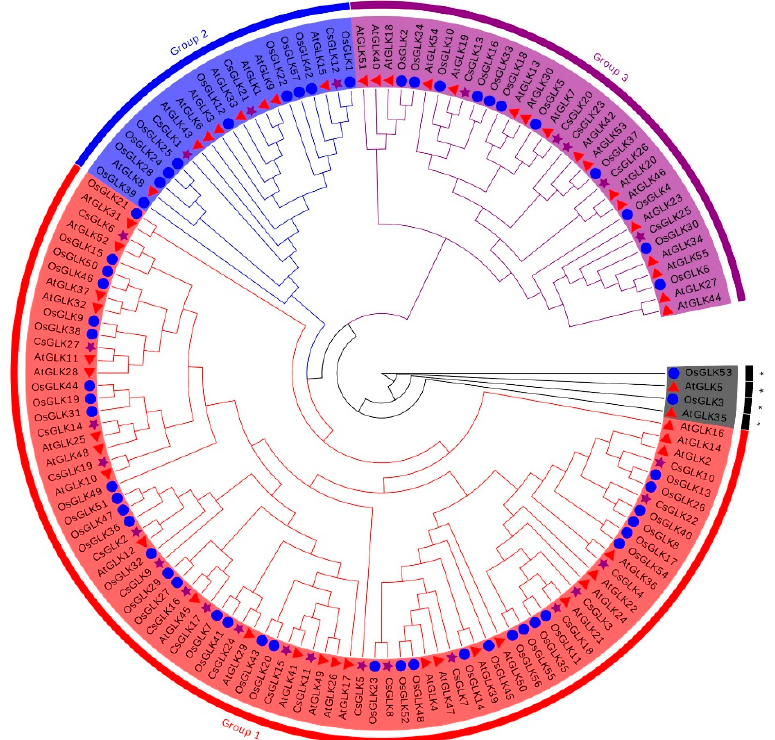
Figure 1. Phylogenetic analysis of Citrus sinensis, Arabidopsis thaliana and Oryza sativa GLKs. Circles of different colors represented different subgroups. ☆ represented citrus, ○ represented maize and △ represented Arabidopsis. * referred to proteins that were not clustered. The tree was constructed from amino sequences using MEGA‑X software by the neighbor‑joining program with 1000 bootstrap replicates. Clades with different colors represent diverse